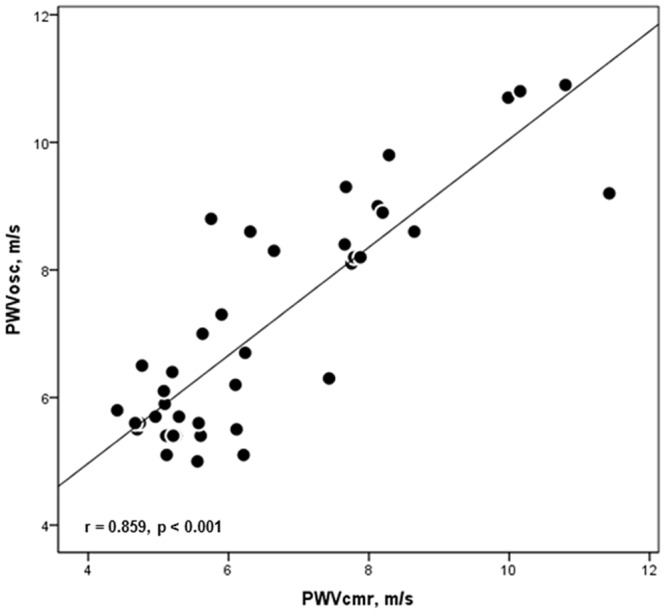
Correlation of aortic pulse wave velocity assessed by the two methods.Linear correlation between aortic pulse wave velocities assessed by brachial oscillometry (PWVOSC) and cardiac magnetic resonance (PWVCMR).